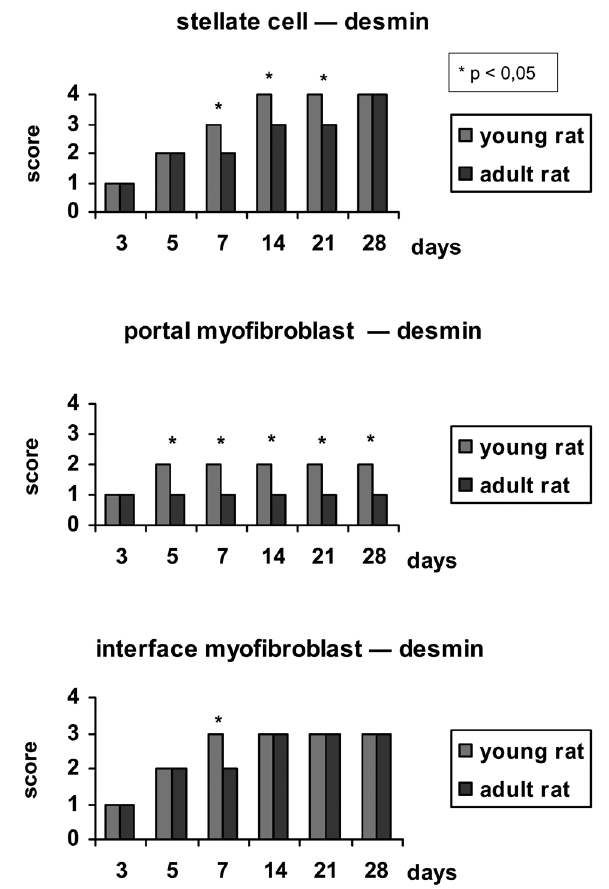
Figure 1 - Bar chart showing the expression of desmin at each phase of the experiment in young rats (YR) and adult rats (AR). The values expressed are